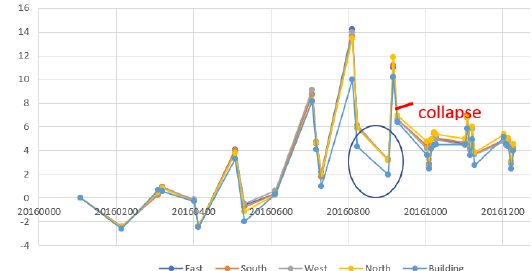
Figure 14. Displacement on Building 2 location, and its neighbours.